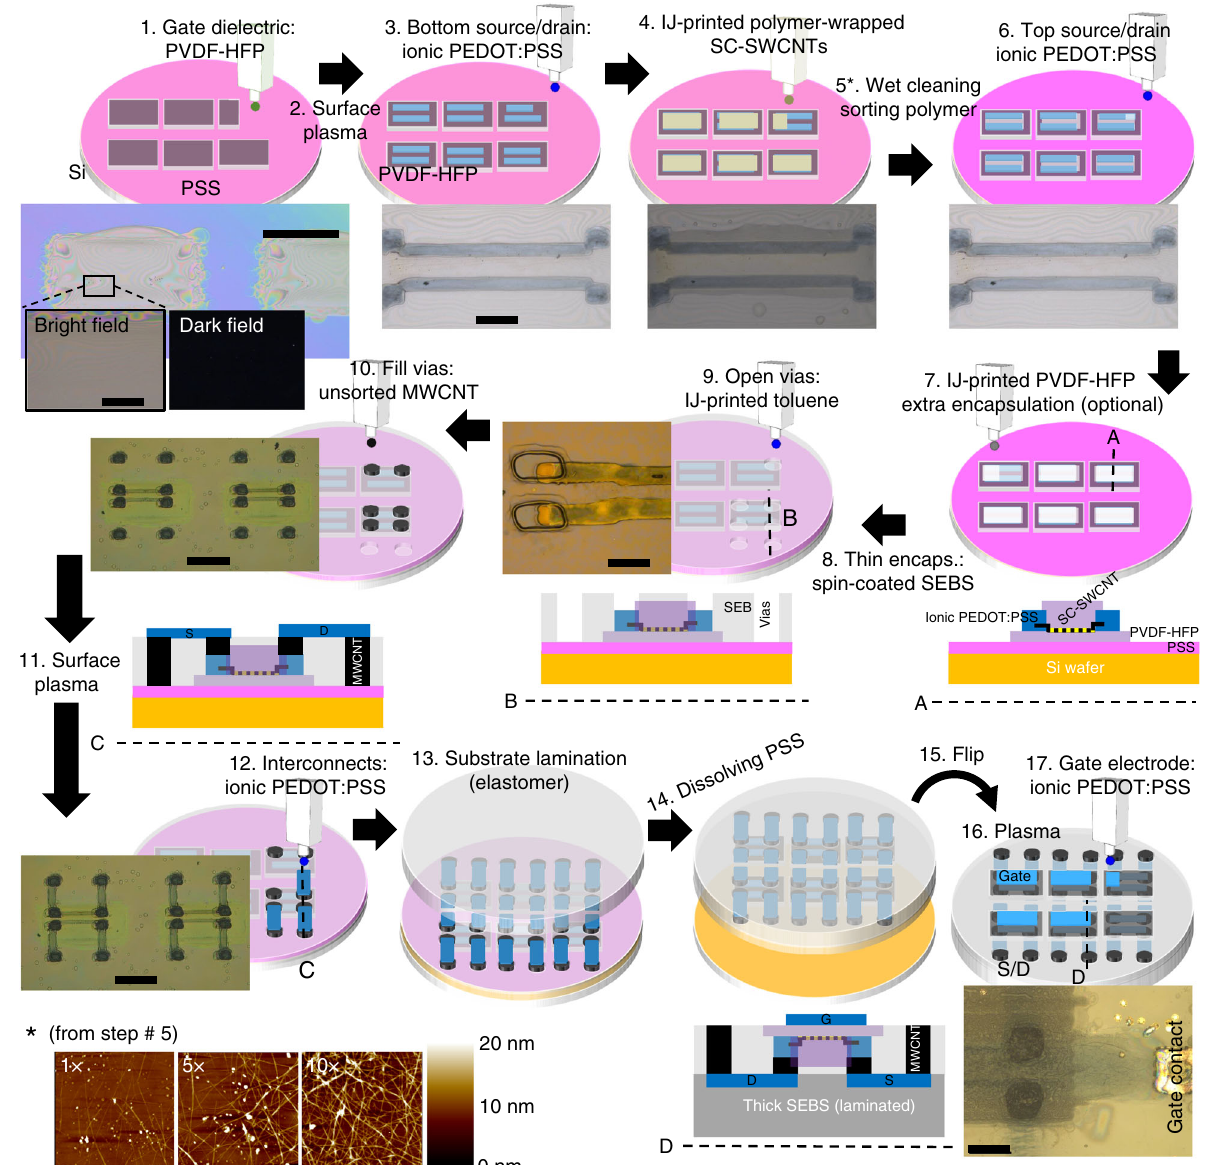
Fig. 2 Detailed fabrication of the inkjet (IJ)-printed stretchable single-walled carbon nanotube- fi eld effect transistor (SWCNT-FET) arrays. The process steps are numbered and presented in chronological order of fabrication along with a simpli fi ed three-dimensional (3D) or cross-section view sketch. Representative optical pictures of the devices after some steps are also added for clarity. The atomic force microscopy (AFM) amplitude topographies in the inset at the bottom-left corner of the fi gure corresponds to step #5. It shows how the SWCNT density (number of tubes per surface area) of IJ-printed semiconductor (SC)-SWCNTs networks can be easily tuned by the number of printing passes: the network resulting from 1, 5, and 10 printing passes on a SiO 2 substrate is shown after removal of the sorting polymer. Scale bar = 200 μ m in steps: 1 (zoom), 3, 9, and 17. Scale bar = 1 mm in steps: 1, 10, and